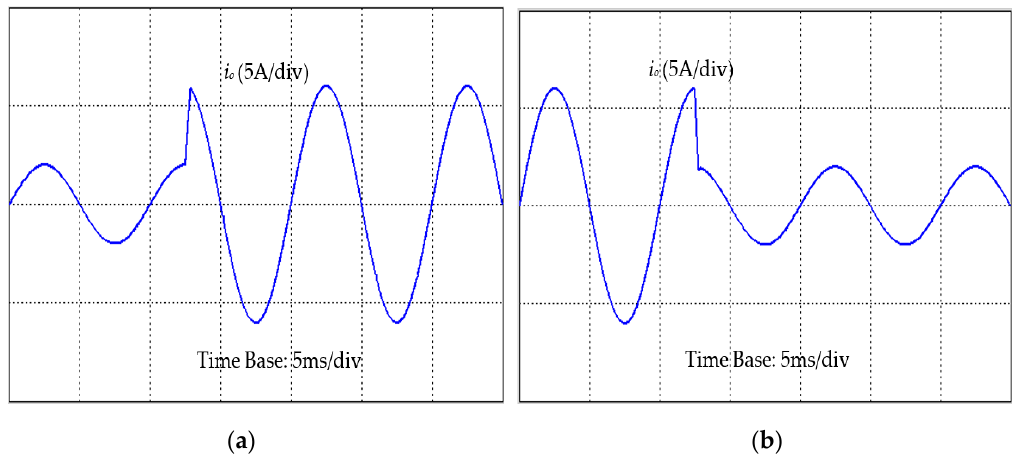
Figure 21. Simulation results of the load dynamic response: ( a ) a step change from 12.5% to 75% rated output power; ( b ) a step change from 75% to 12.5% rated output power.